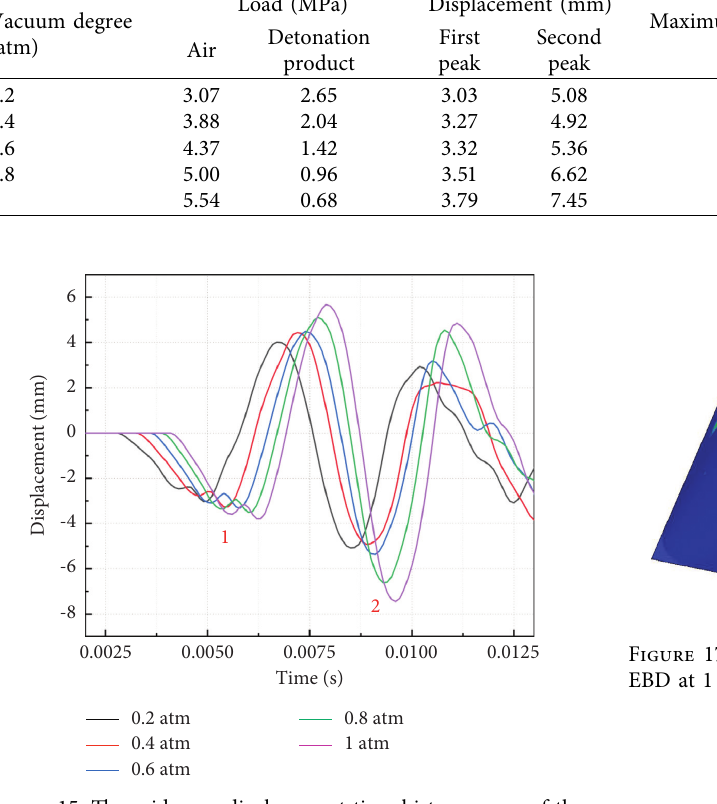
Figure 15: The mid-span displacement time history curve of the EBD under different vacuum degrees.